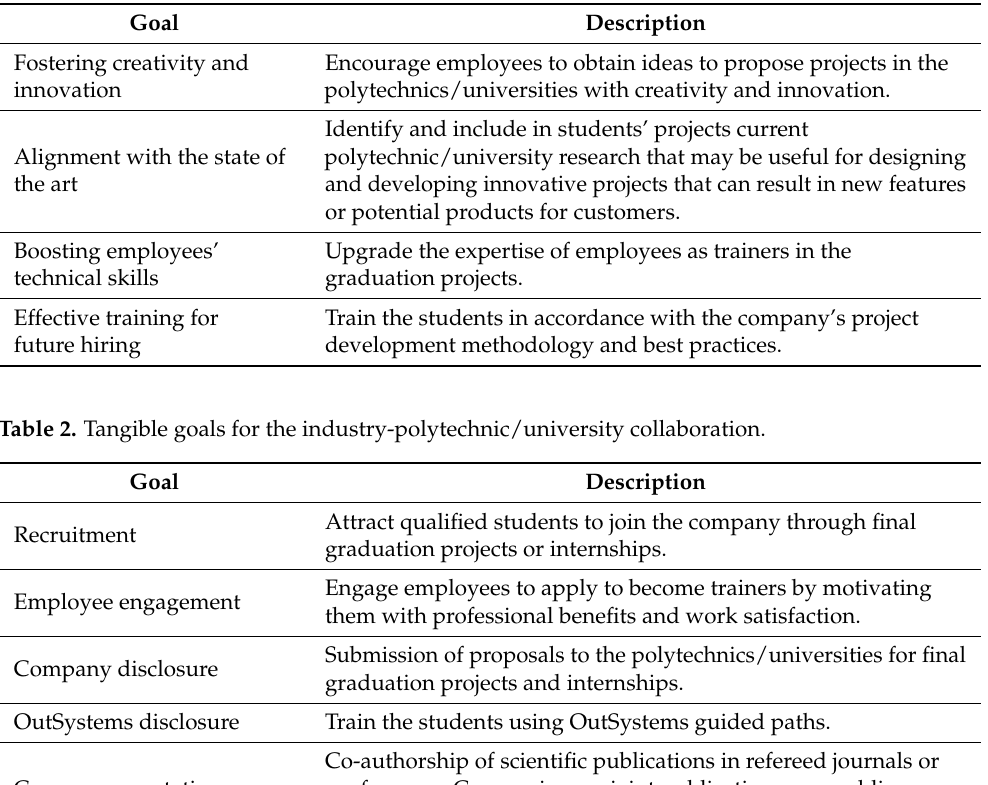
Table 1. Intangible goals for the collaboration between industry–polytechnics/universities.